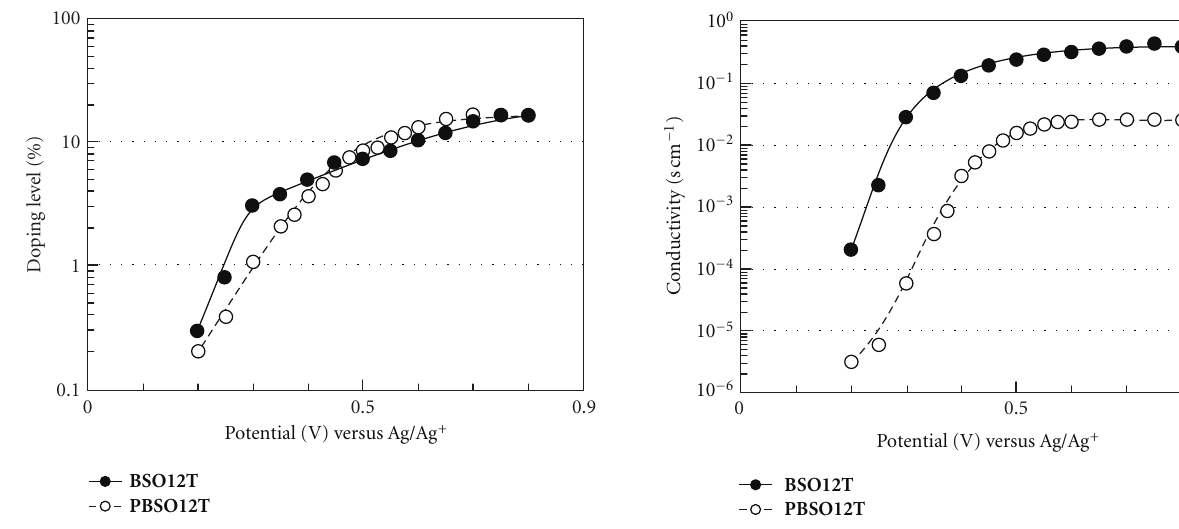
Figure 12: In situ electrical conductivities plotted against electrode potential for (cid:2) : BSO12T and (cid:4) : PBSO12T